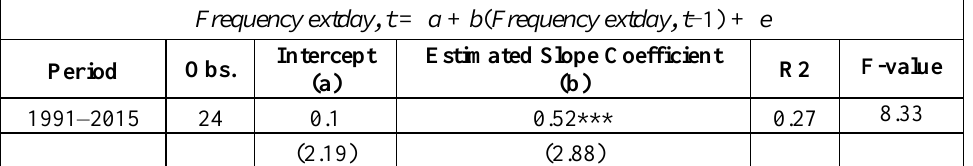
Table 3. OLS-model estimates of annual extreme day return frequencies for overall sample period